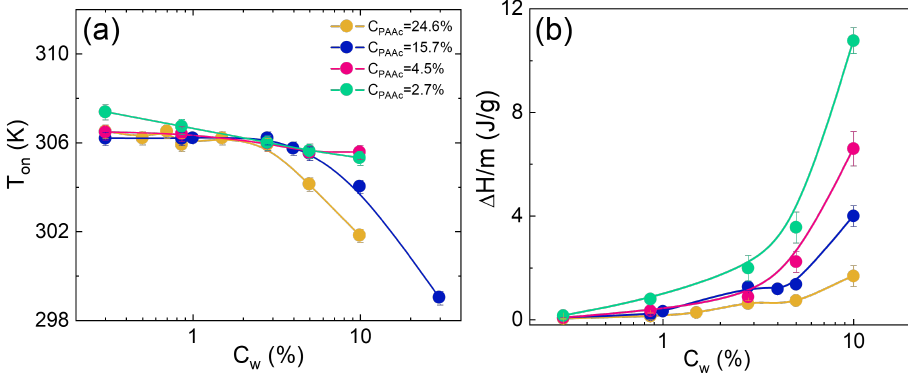
Figure 8. ( a ) T onset and ( b ) ∆ H/m versus C w for IPN microgels with different PAAc contents at pH 5.5.